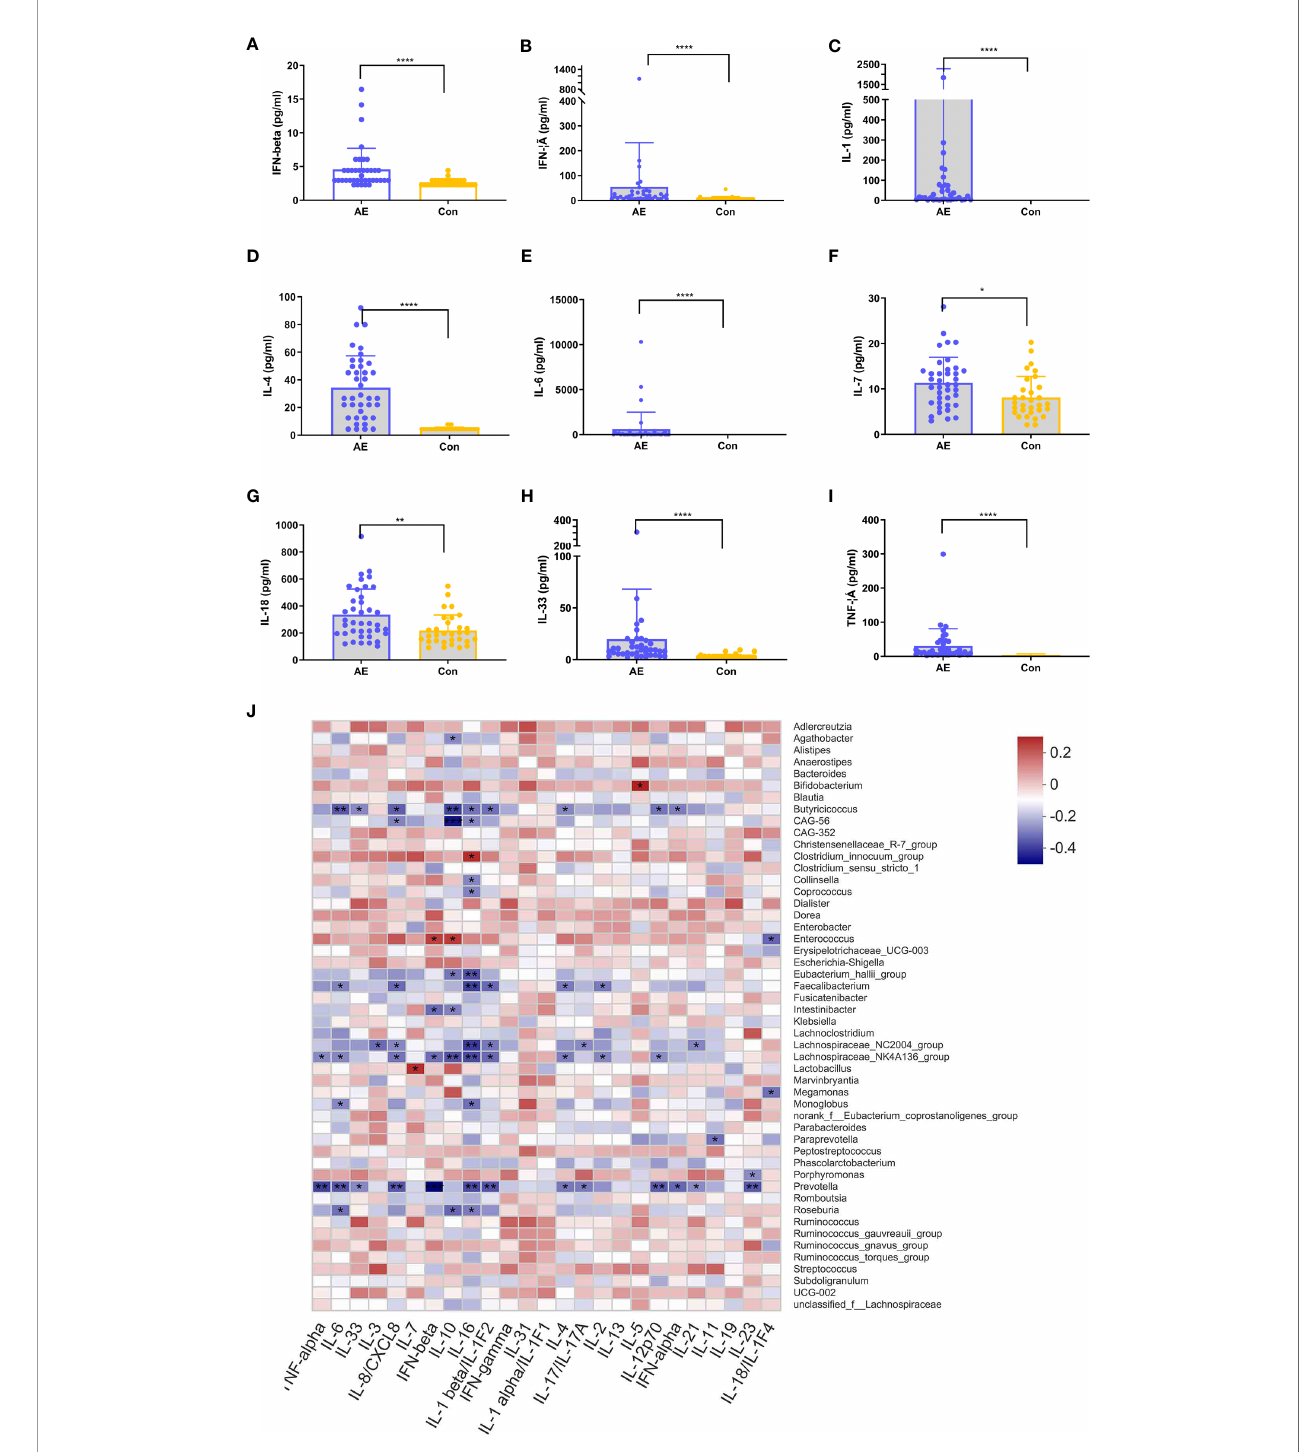
FIGURE 6 | Correlation between dysregulated cytokines and differential genera in anti- N -methyl- D -aspartate receptor (NMDAR) encephalitis. (A – I) Analysis of 12 immune cytokines in patients with NMDAR encephalitis and in healthy controls (HCs). Participants ’ sera were run on Luminex. Differences are determined by a t -test. (J) Correlation analyses of cytokines and differentially enriched genera between any two groups. Abundance rates of differentially enriched species (top 30) in HCs and NMDAR encephalitis were evaluated for association with differential immune factors using Spearman ’ s correlation analysis. Correlations are shown by color gradients from green (negatively correlated) to purple (positively correlated). Correlation coef fi cients and p -values (* p < 0.05, ** p < 0.01, *** p < 0.001, **** p < 0.0001) are